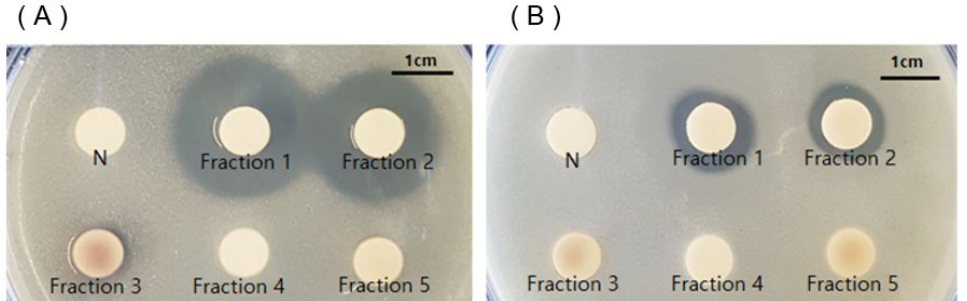
Figure 3. Antimicrobial activity of fractions from silica gel column chromatography to which ethyl acetate extract of Smilax china L. root was subjected. ( A ) C. acnes KCTC 3314; ( B ) C. acnes KCTC 3320. N, negative control (DMSO, 100%); Fractions 1~5, fractions from silica gel column chromatography.